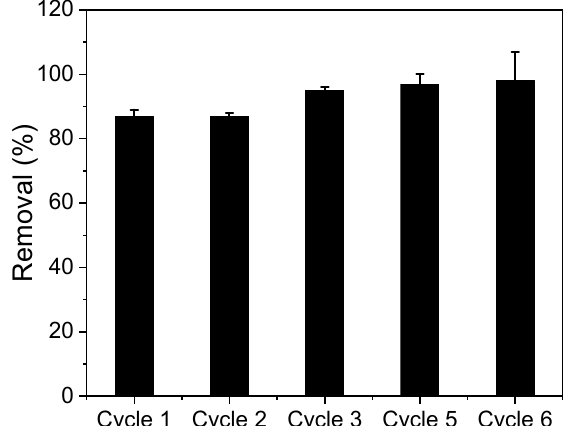
Figure 11. ATZ photocatalytic degradation using Co3O4-4%Ni+rGO SG for up to 6 application cycles.